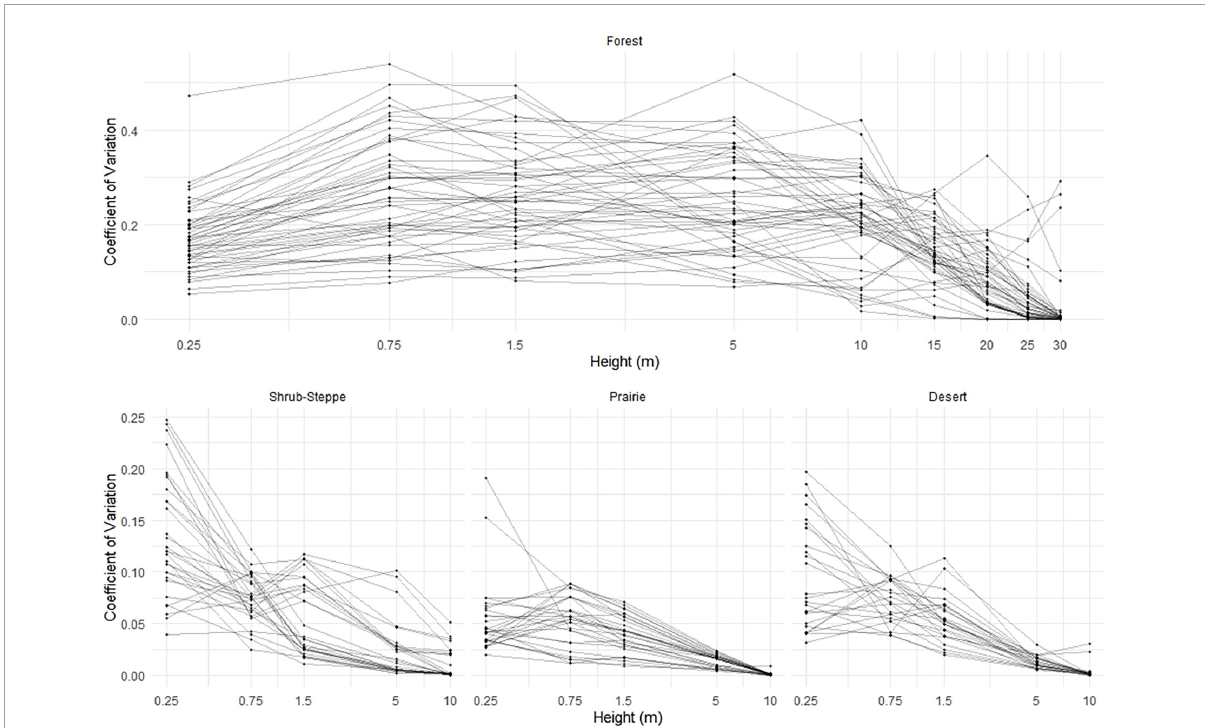
FIGURE6 Variability of viewsheds (estimated as the coefficients of variation) as a function of eye-height across four ecosystems (forest, shrub-steppe, prairie, and desert). Points represent viewsheds at individual vantage points ( n = 25–45/plot) within multiple plots per ecosystem ( n = 5–10 plots/ecosystem). Note that the x-axis is on a logarithmic